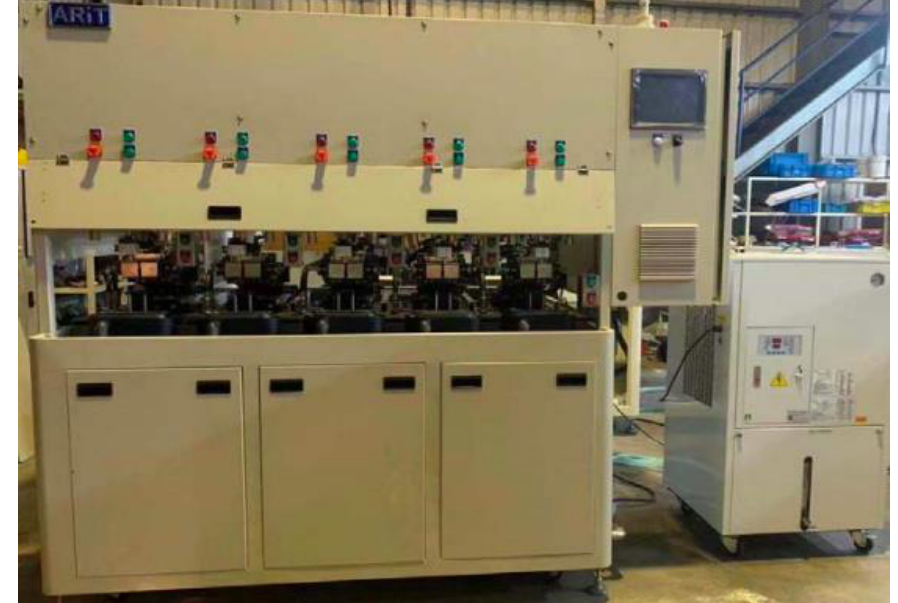
Figure 2. Vacuum degassing equipment.